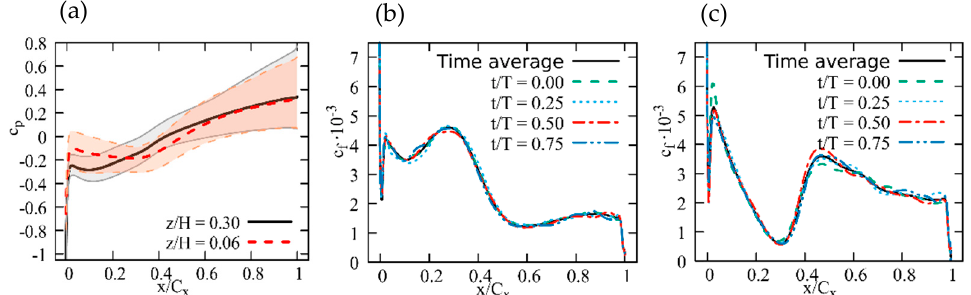
Figure 17. Effect of incoming wakes on blade performance characteristics at the suction side near the blade tip (z/H = 0.06) and in the midspan region (z/H = 0.30). ( a ) Time averaged pressure coefficient (Equation 3) with shaded areas denoting the span of transient fluctuations. ( b , c ) Friction coefficient ( c (cid:2916) ) near the blade tip and in the midspan region, respectively.